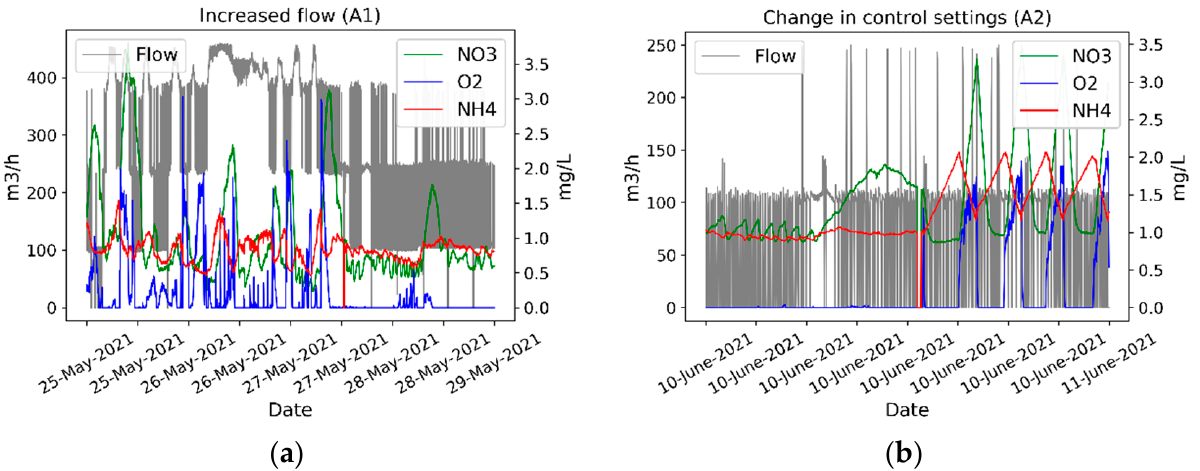
Figure 2. Examples of anomalies detected in WWTP1 PCT1. ( a ) increased flow, ( b ) change in control settings.